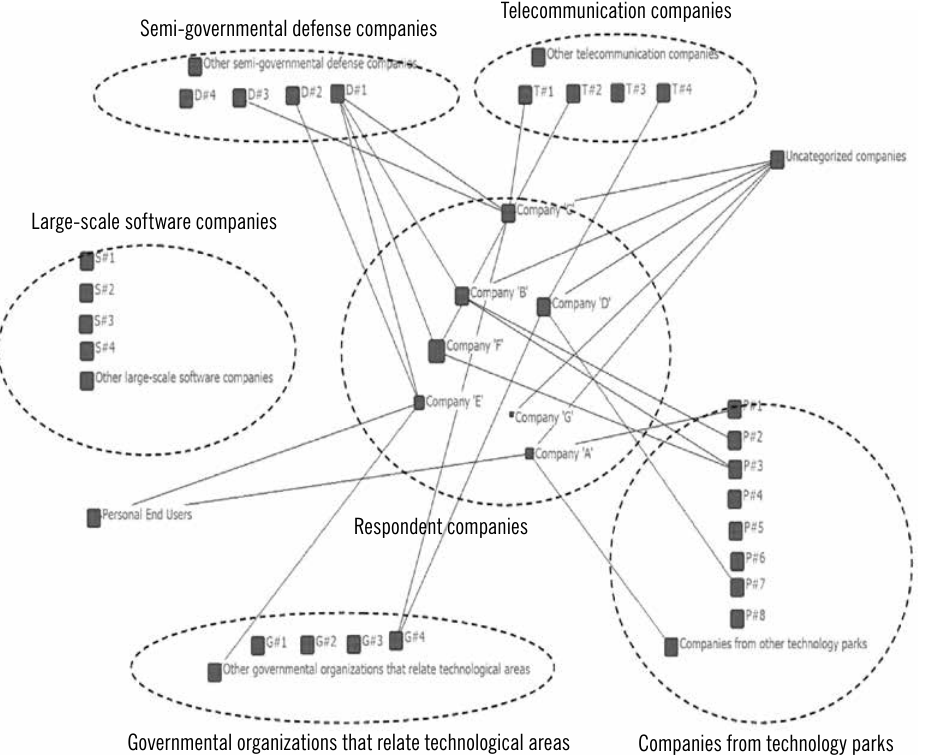
Figure 2. Social network map with weighted relations